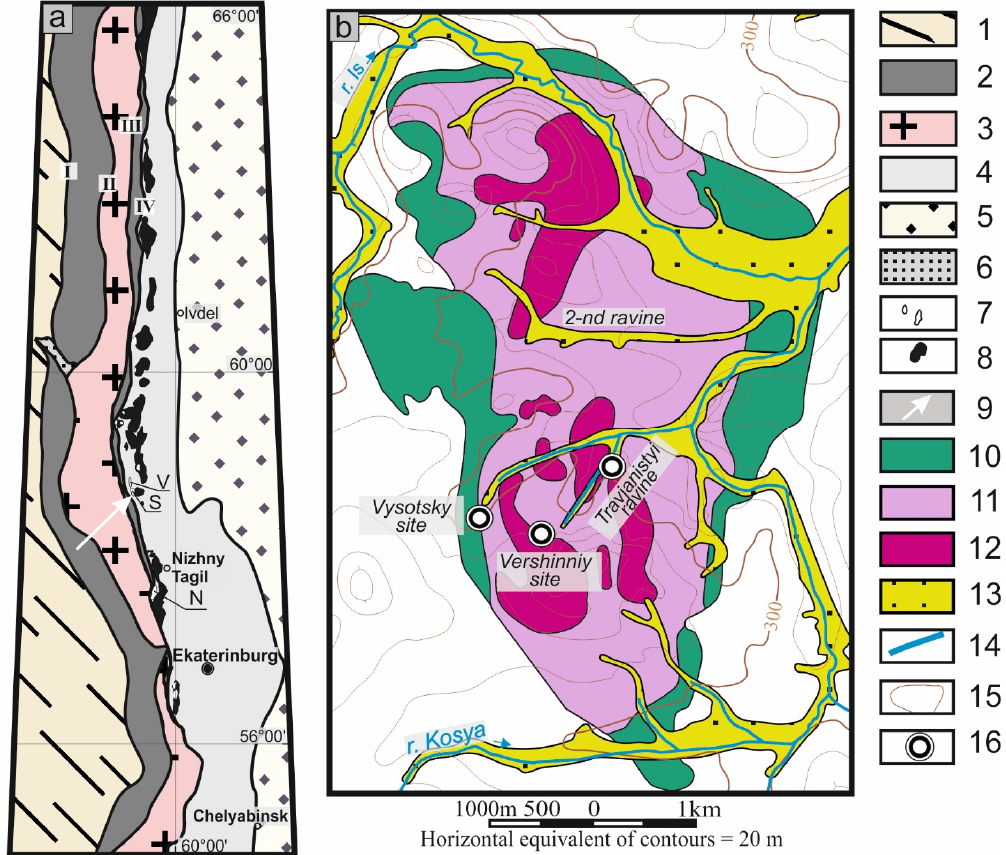
Figure 1. ( a ) The Ural-Alaskan type massifs in the structure of the Urals (compiled from state geological maps of 1:1,000,000 scale): 1—Paleozoic of the East European Platform; 2—Western Ural fold-thrust zone; 3—Central Ural uplift; 4—Tagilo-Magnitogorskaya megazone; 5—sedimentary cover of the West Siberian platform; 6—Polyudovsk uplift; 7, 8—the massifs of the Ural Platinum Belt: 7—dunite bodies, 8—pyroxenites, gabbros, volcanites; 9—the location of Svetloborsky clinopyroxenite-dunite massif. Roman numerals indicate the main faults (thrusts): I—Main Western Ural; II—Osevoy; III—Prisalatimsky; IV—Main Uralian Fault. Letters denote the Ural-Alaskan type massifs: N—Nizhnetagilsky, S—Svetloborsky; and V—Veresovoborsky. ( b ) The Svetloborsky massif’s geological structure, compiled from [5] with additions: 10—pyroxenites; 11–12—dunites: 11—fine-, small-grained, 12—medium-grained; 13—alluvial sediment; 14—rivers, streams; 15—contour lines; and 16—sites of detailed sampling.